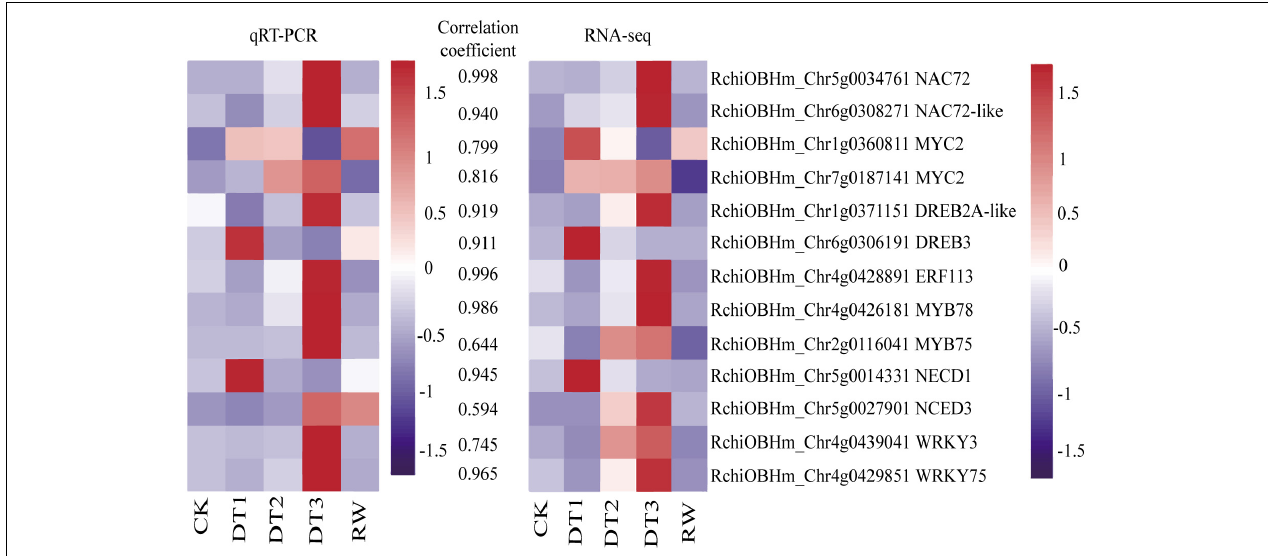
FIGURE 9 | Heatmaps of the validation and correlation analysis of 13 selected DEGs. The values between the two heatmaps represent the correlation coefficients of qRT-PCR and RNA-seq values from each gene.